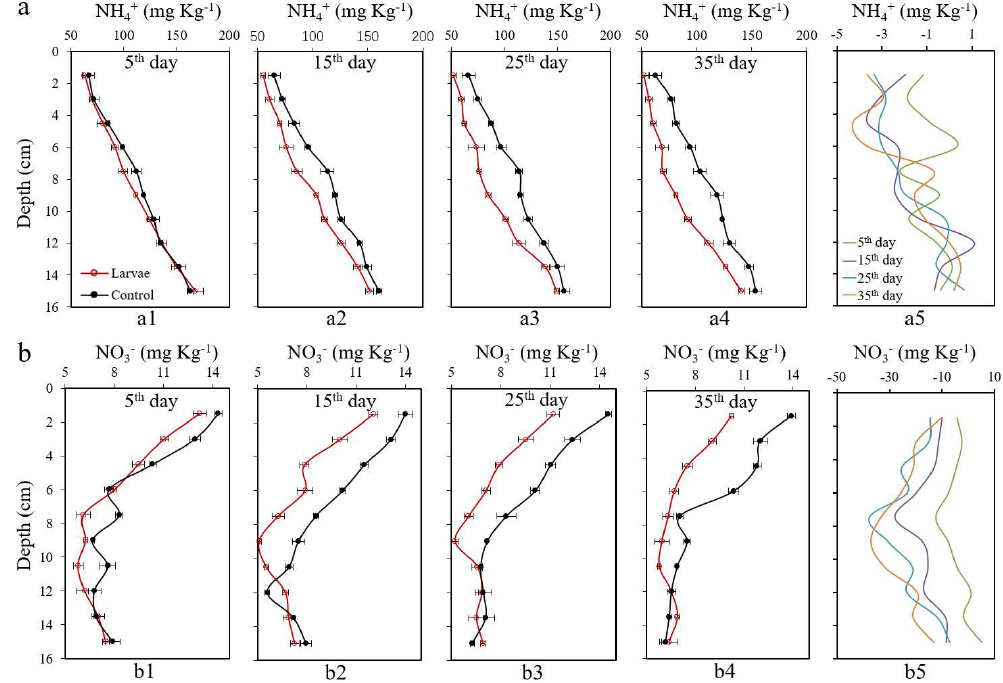
Figure 4. Ammonium nitrogen (NH 4+ ) and nitrate nitrogen (NO 3− ) profiles in sediments of the control and the Chironomid larvae treatment. ( a ) NH 4+ and ( b ) NO 3− . ( a5 ) NH 4+ and ( b5 ) NO 3− in sediments changes in treatment minus changes in control on the 5th, 15th, 25th and 35th day, respectively.